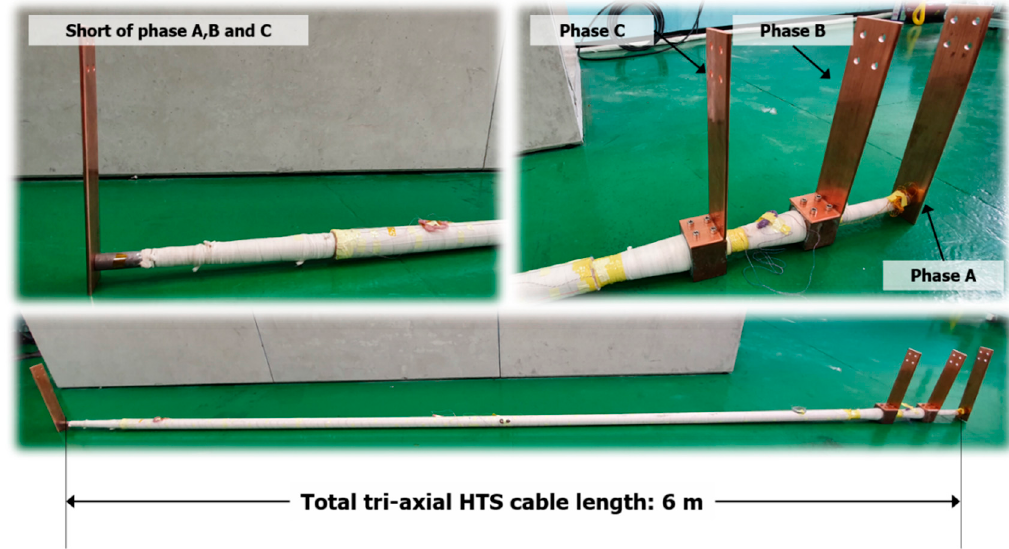
Figure 7. Six-meter-long 23 kV / 60 MVA-class tri-axial HTS power cable.